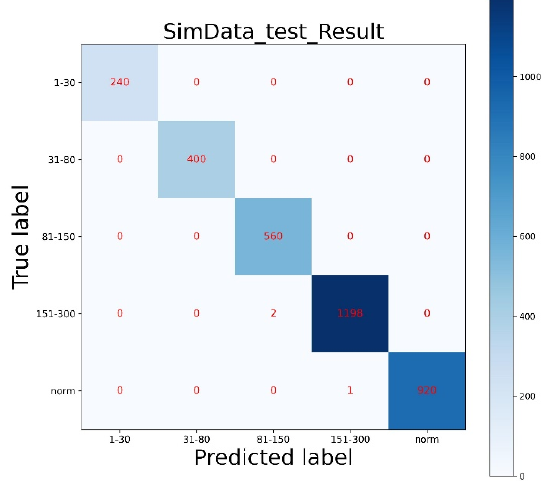
Figure 9. Fault classification prediction results of battery simulation data test set.